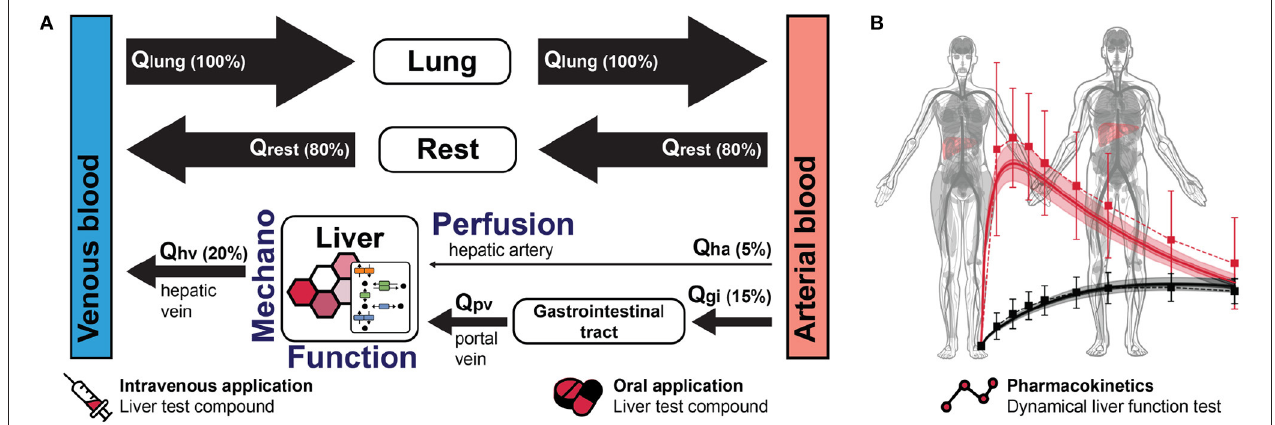
FIGURE 6 | Physiologically based pharmacokinetic (PBPK) model for liver function at the whole-body scale. (A) PBPK models include organs and the systemic circulation between these organs. The liver receives approximately 20% of the cardiac output as blood flow with one-quarter from the hepatic artery and the remainder from the portal vein. Liver function depends on hepatic perfusion and metabolism, as well as on mechanical tissue properties, which can influence hepatic function either directly via changes in blood flow or indirectly by changes in metabolism following mechanotransduction. In the example, all organs besides the liver and the lung have been pooled in the Rest compartment for simplicity. Q lung , blood flow lung; Q ha , blood flow hepatic artery; Q gi , blood flow gastrointestinal tract; Q pv , blood flow portal vein; Q hv , blood flow hepatic vein; Q rest , blood flow rest of body. (B) The pharmacokinetics of liver test compounds, as measured in dynamic liver function tests such as ICG elimination or LiMAx, allows assessment of liver function at the whole body scale. Shown here in red caffeine (test compound) and in black paraxanthine (main product) in an example liver function test based on caffeine. PBPK models are excellent for modeling these tests. Anatomograms under CC-BY Papatheodorou et al.